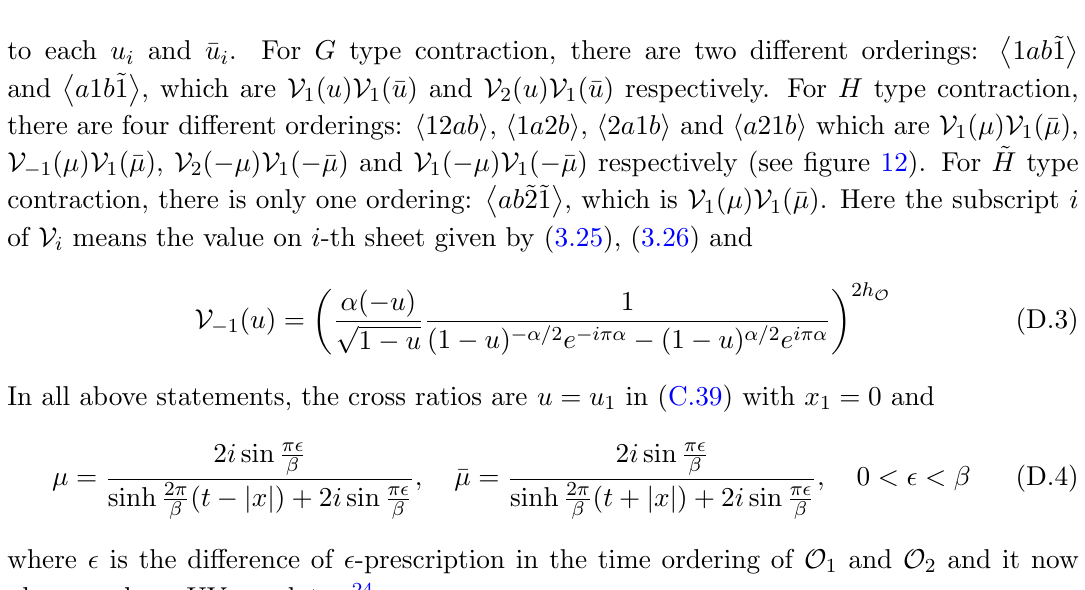
Figure 12 . The plot of (cid:22) and (cid:22) (cid:22) . The blue, yellow, green, red and purple are for h 12 ab i , h 1 a 2 b i , (cid:10) (cid:11) h 2 a 1 b i , h a 21 b i and ab ~2~1